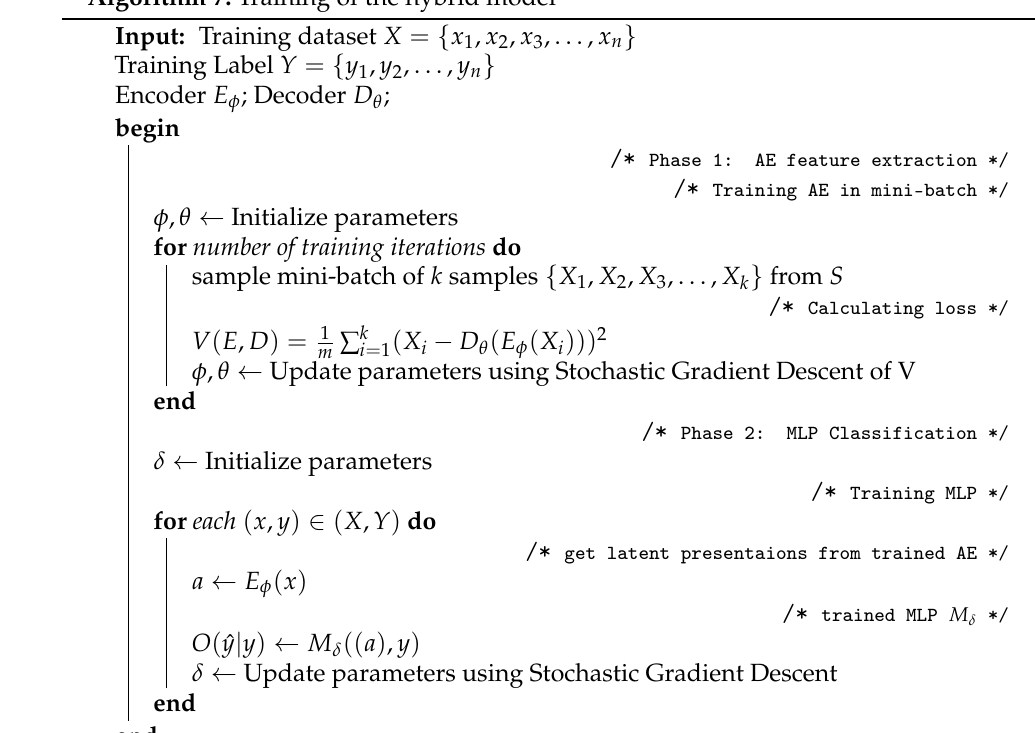
Algorithm 7: Training of the hybrid model